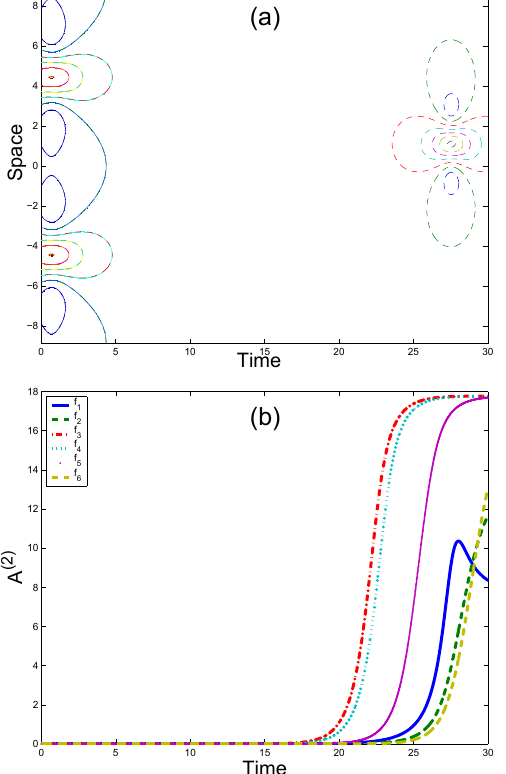
Figure 6. (a) Contours of | U (cid:15) (x,t) | (dashed line) and the one-mode SPB | U ( 2 ) (x,t ; ρ ∗ ) | (solid line) over a plane wave with two UMs. (t) for each f i . (b) Evolution of A ( 2 ) i